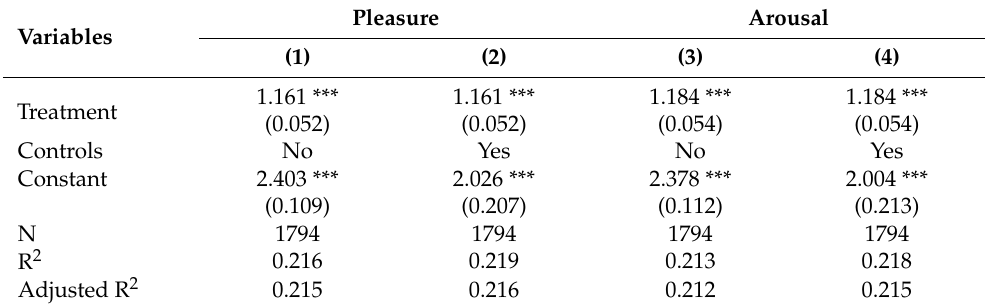
Table A6. The effect of traffic lanes on tourists’ momentary emotional experience.